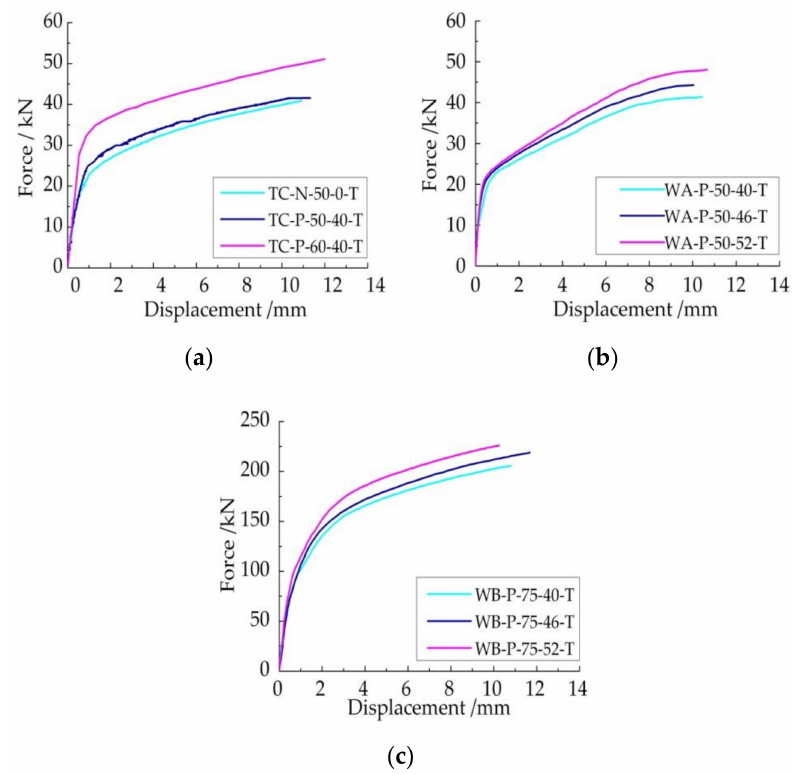
Figure 5. Relation curves between axial force and displacement measured in a monotonic tensile test, representing specimens in groups ( a ) TC, ( b ) WA ( c ) and